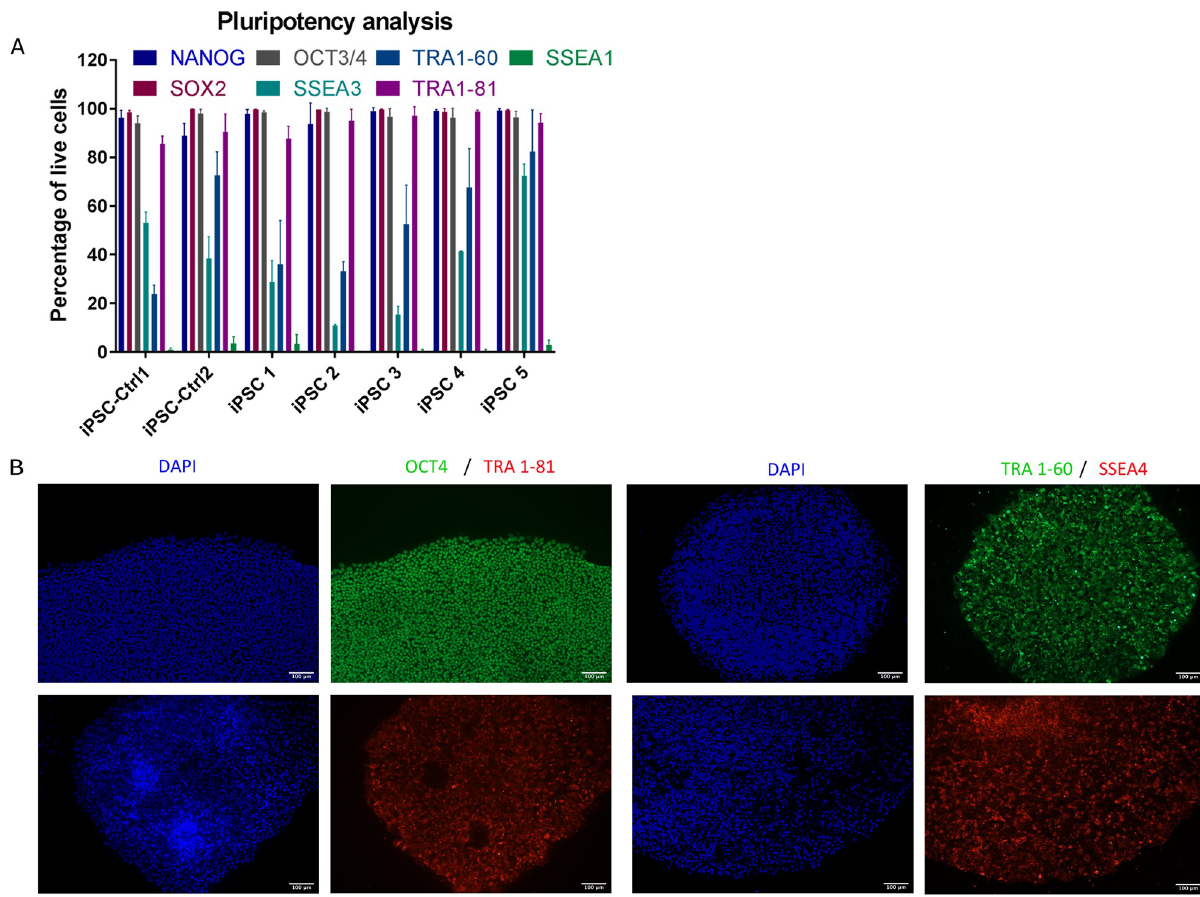
Fig 5. (A) Flow cytometric analysis of iPSC clones for pluripotency markers from a representative centenarian donor (105-years old) compared to 2 iPSC-Ctrl lines. Data represent n = 3 different experiments. (B) Immunostaining of iPSC colonies for pluripotency markers, nuclear markers (OCT4) and surface markers (TRA1-81, TRA1-60 and SSEA4); DAPI images of all pictures are included.